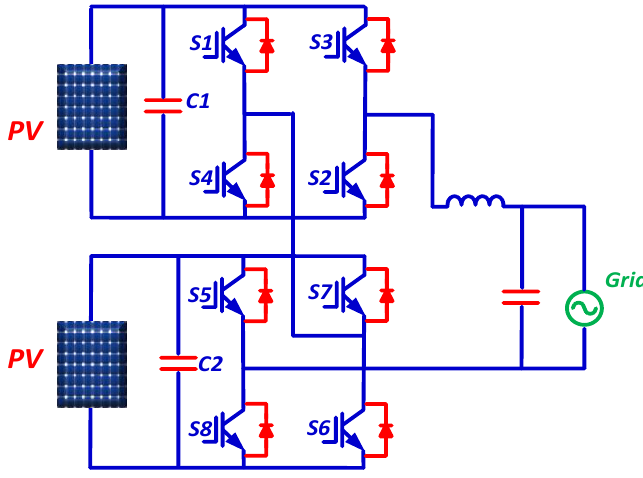
Figure 6. Cascaded inverter [52].